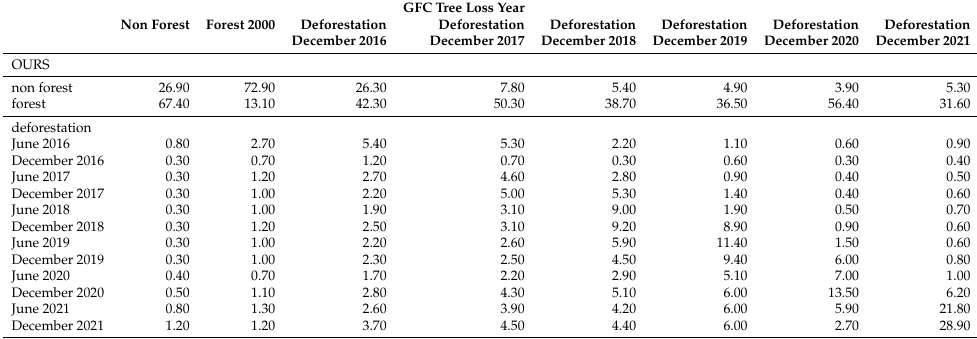
Table 4. Intersection in percentage of annual GFC tree loss data and our bi-annual deforestation